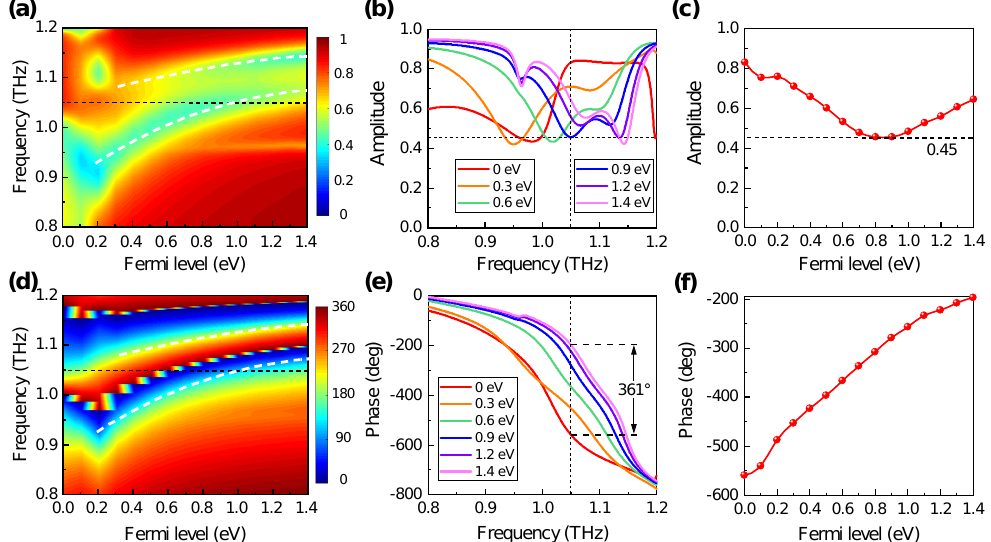
Figure 2. Simulated reflection ( a , b ) amplitude and ( d , e ) phase spectra for different graphene Fermi levels. Reflection ( c ) amplitude and ( f ) phase as functions of the graphene Fermi level at 1.05